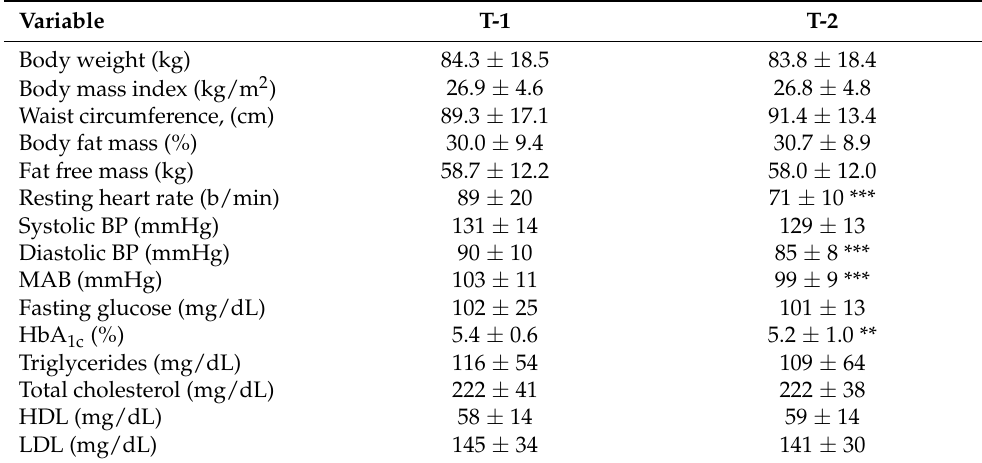
Table 2. Mean values and standard deviations (SD) of participants’ (N = 71) body composition and cardiometabolic data at baseline (T-1) and post-intervention